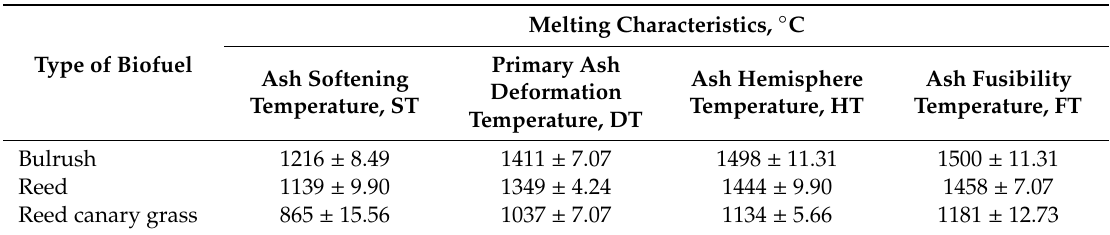
Table 3. Ash melting temperatures.